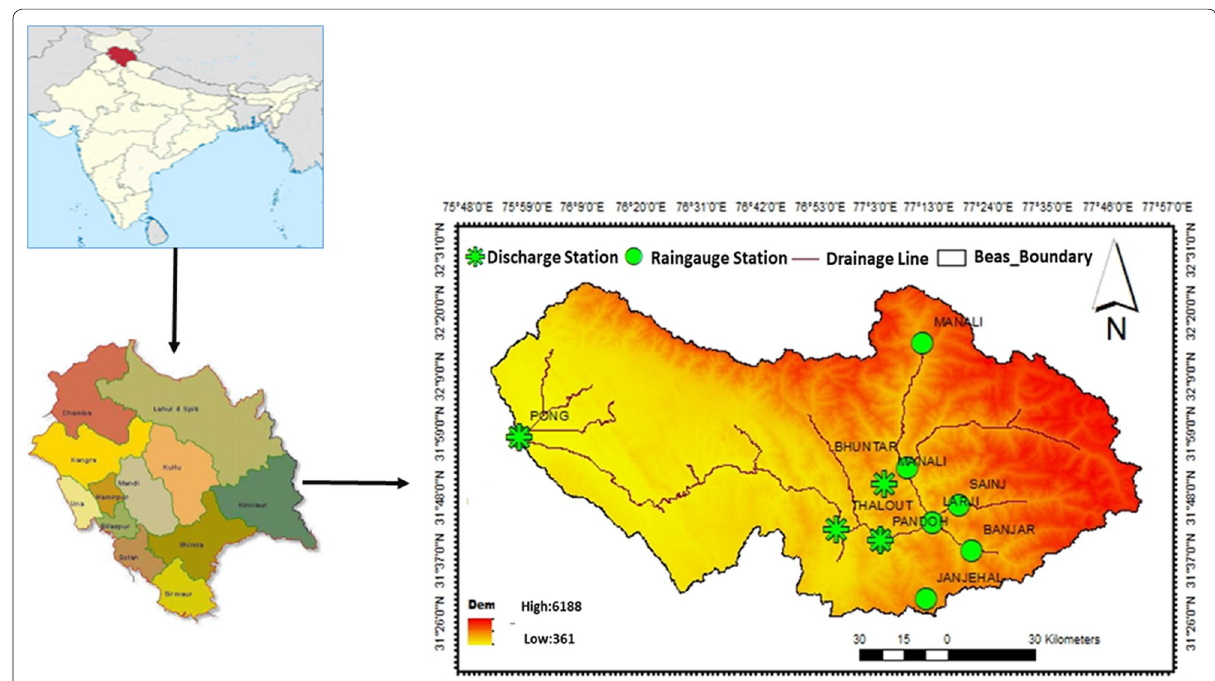
Fig. 1 Study area of Beas river